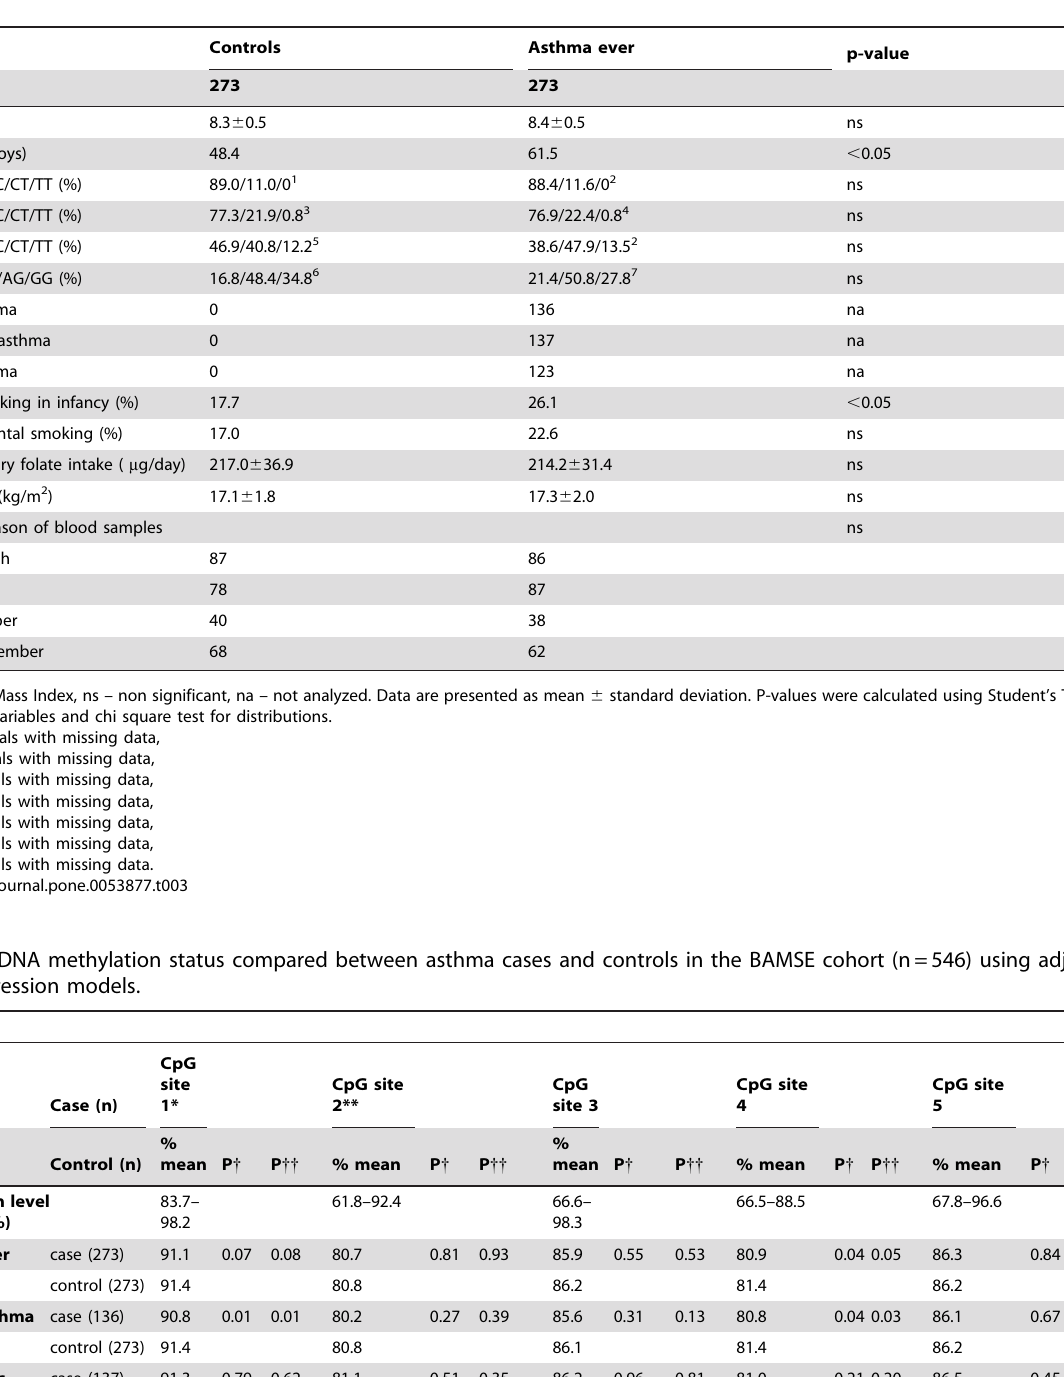
Table 3. Characteristics of the BAMSE study population (n=546).